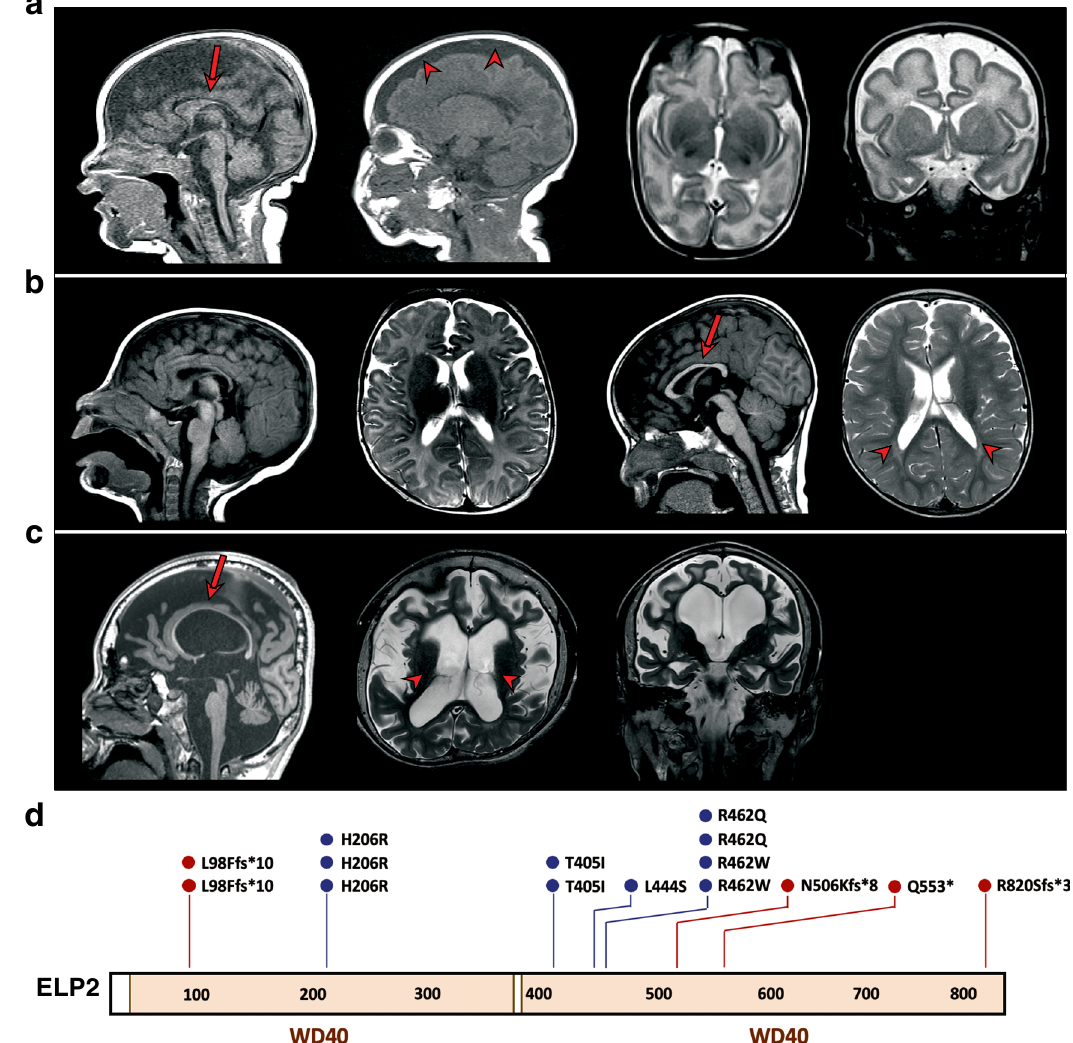
Fig. 1 Molecular and clinical information on the ELP2 variants found in patients with intellectual disability and autism. a Mid- and lateral-sagittal (left), transversal (middle), and coronal (right) MRI scans of Patient 4 (refer to Supplementary Table 1.) revealing microcephaly with few and shallow sulci. b Sagittal and transversal MRI brain scans of Patient 5 showing normal brain at 3 months (two panels left) and decreased white matter, secondary ventricular enlargement, and thin corpus callosum at 19 months of age (two panels right). c Sagittal (left), transversal (middle) and coronal (right) brain MRI scans of 17-years-old Patient 6 showing microcephaly and severe brain atrophy (cortex, cerebellum, and brain stem atrophy) with white matter loss, secondary ventricular enlargement, and thin corpus callosum. Arrows indicate thin corpus callosum and arrowheads point to a broadened subarachnoid space in ( a ) and ventricular enlargement in ( b ) and ( c ). d Schematic representation of the ELP2 mutations identi fi ed in patients with intellectual disability and autism. WD40 protein domains are shown in orange. Position of missense (in blue) and frameshift (fs) mutations (in red) is